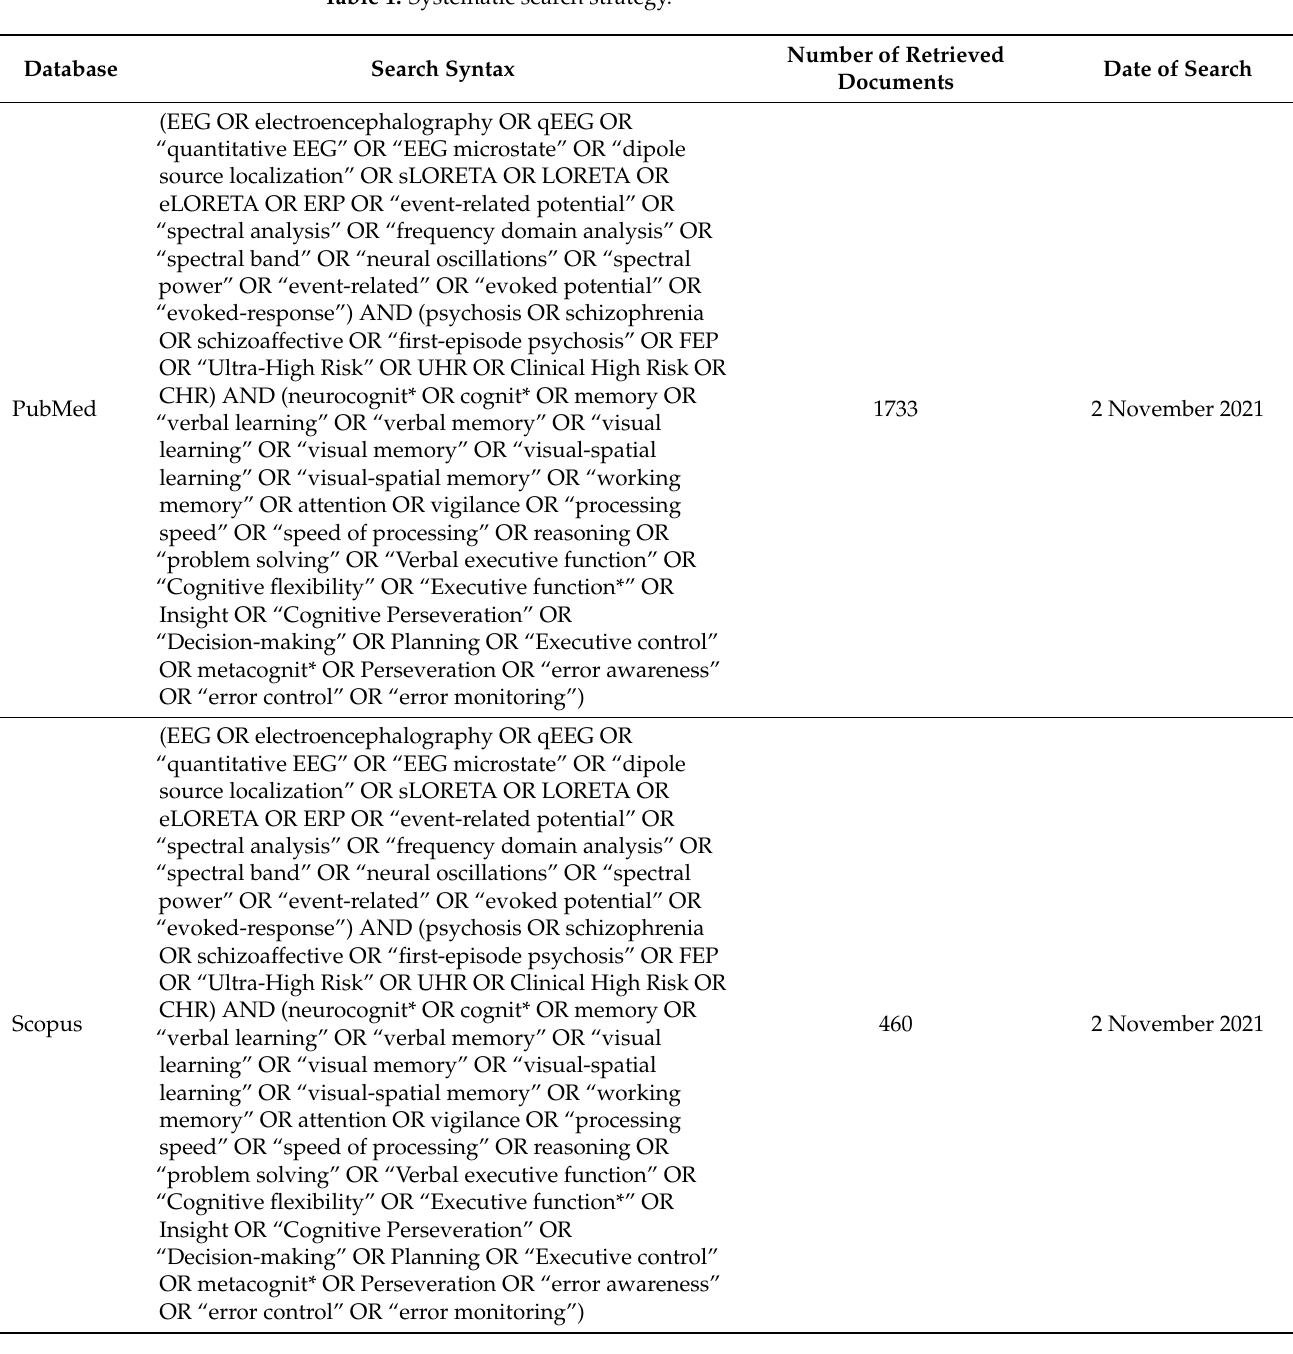
Table 1. Systematic search